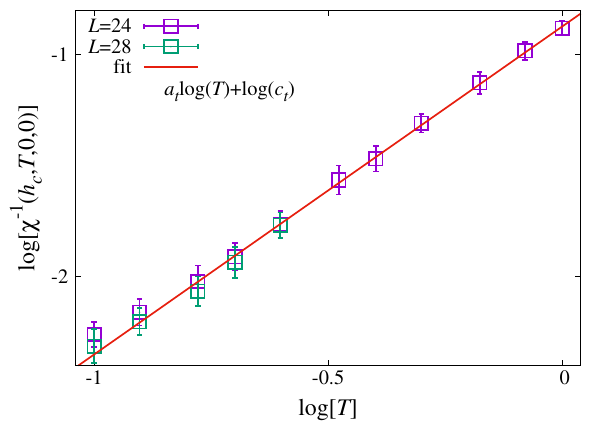
FIG. 8. Inverse Ising spin susceptibility at QCP [ χ − 1 ð h c ; T; 0 ; 0 Þ ] as a function of temperature T . The slope of the log-log plot reveals the power a t ¼ 1 . 48 ð 4 Þ , and the intercept gives rise to the prefactor c t ¼ 0 . 13 ð 1 Þ .